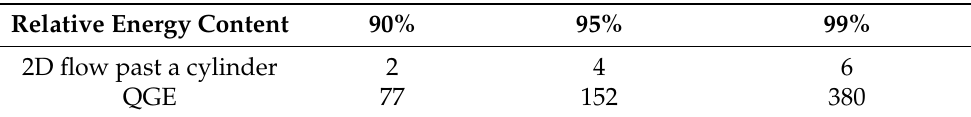
Table 1. Number of ROM modes needed to achieve a given relative energy content (30) for the 2D flow past a circular cylinder with Re = 1000 and the QGE with Re = 450 and Ro = 0.0036 (see Section 5 for